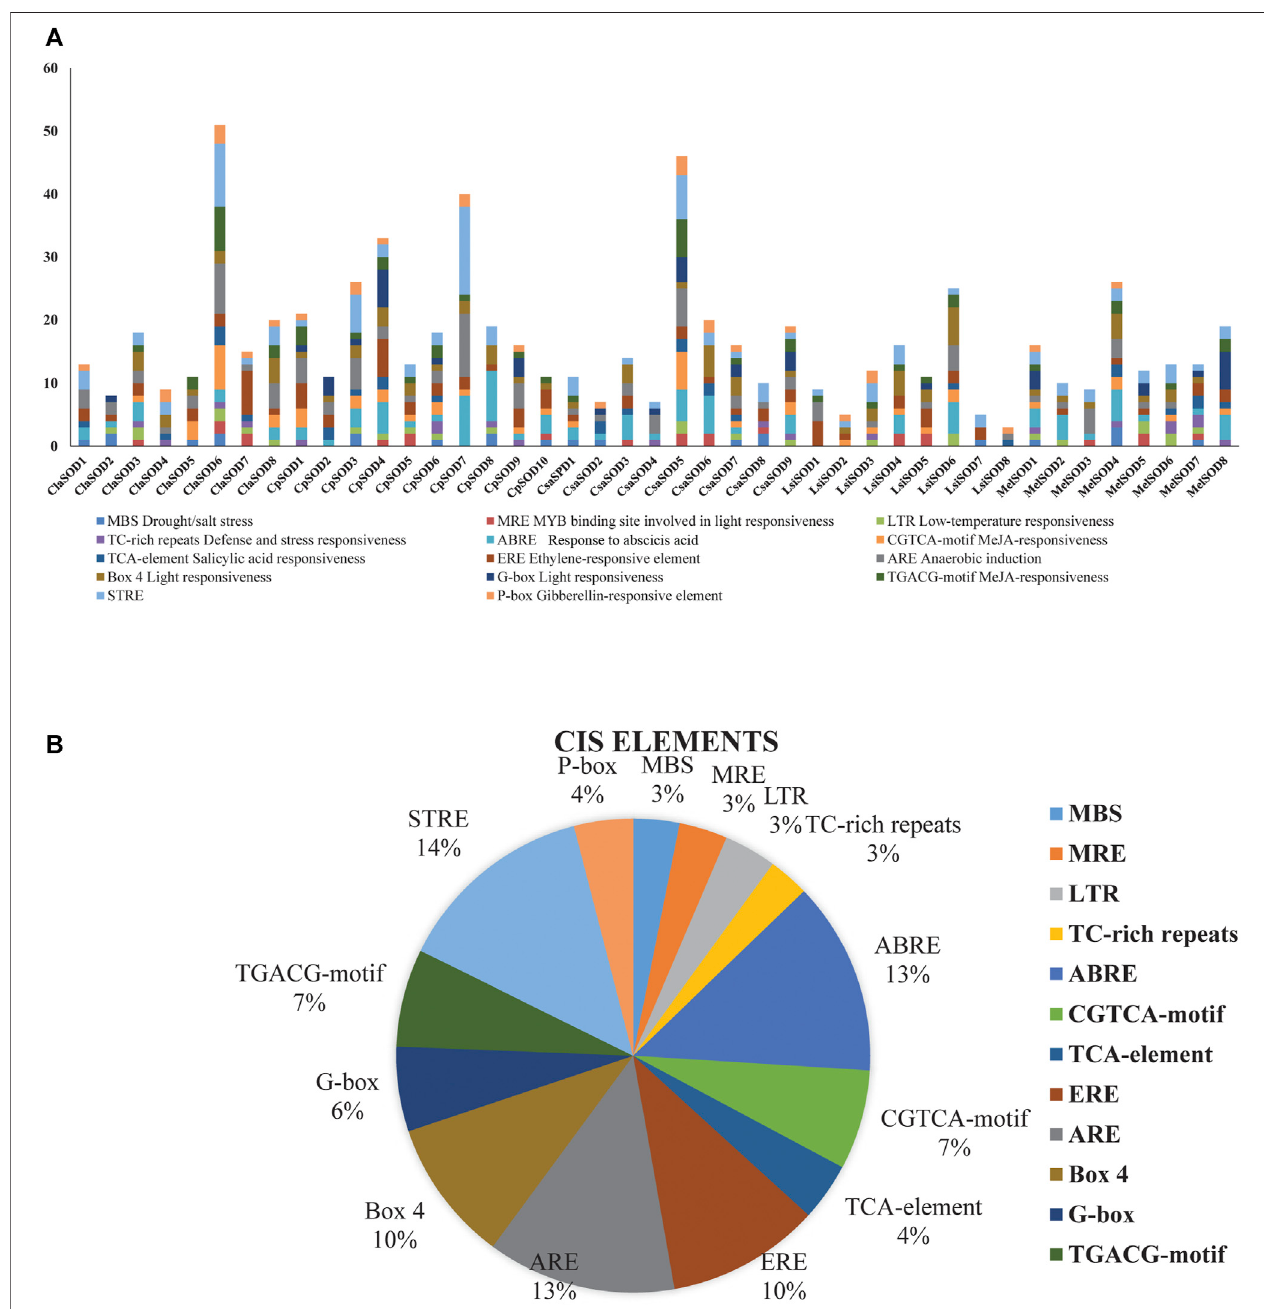
FIGURE 4 | Analysis of cis -elements in putative promoters of SOD gene family of fi ve species of Cucurbitaceae family. 1,500 kb upstream of the transcription initiationsite,sequencesofSODgeneswereretrievedandanalyzedbyPlantCARE. (A) Differentstress-responsiveandhormone-associatedelementsareidenti fi ed,and their numbers are plotted on the graph. Various elements in each promoter are coded in different colors according to the legend at the top. (B) The size of the pie charts showed the percentage of promoter element in each category.